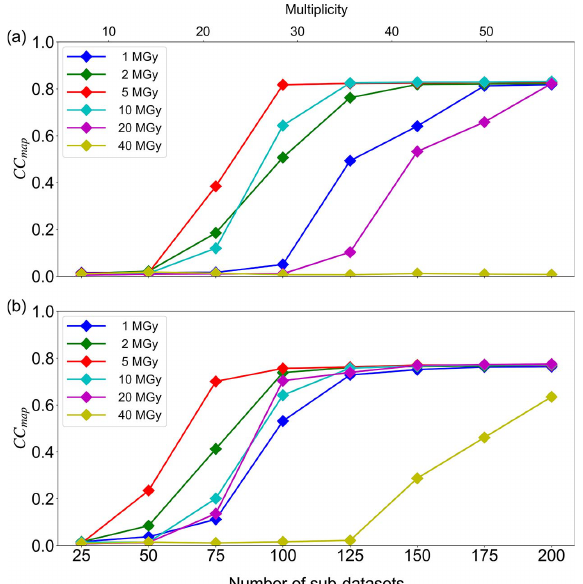
Figure 2 Correlation between the number of data merged for each dose and CC map for ( a ) (cid:2) = 1.4 A˚ , ( b ) (cid:2) = 1.7 A˚ . Mean values of the correlation coefficient (CC map ) derived from the phase determinations for ten randomly selected merged sub-datasets were plotted against the number of